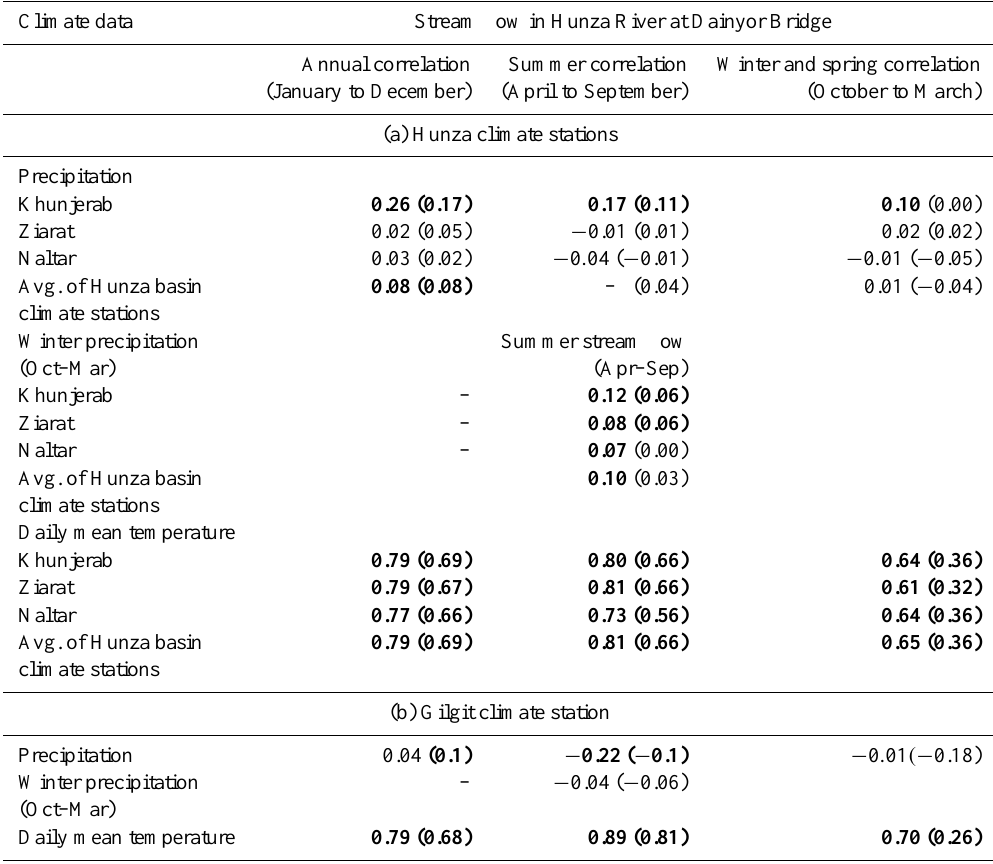
Table 5. Annual and seasonal correlation coefficients between stream flow data at Dainyor (1999–2007) and (a) daily climate data (pre- cipitation and temperature) of Hunza basin climate stations (1999–2007), (b) monthly climate data (precipitation and temperature) of Gilgit station